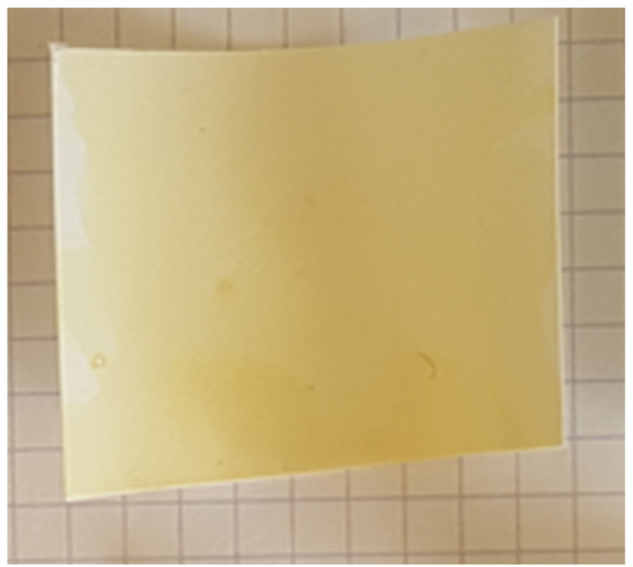
Figure 2. Example of a TFC membrane prepared by coating the Sulzer-PAN support (ca. 5 cm × 5 cm) with a blend of PIM-EA(Me 2 )-TB and Matrimid ® 5218 at 2 wt.% polymer solution. The ELASTOSIL ® M 4601, consisting of a mix of pre-polymer A and crosslinker B in weight ratio 9:1, was dissolved in cyclohexane to obtain a solution composed of 80